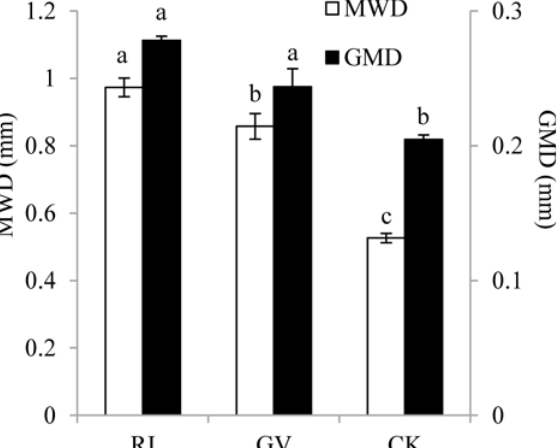
Fig 3. Mean weight diameter and geometric mean diameter of water stable aggregate in the rhizosphere of R . pseudoacacia colonized by R . irregularis (RI), G . versiforme (GV) or not (CV). Significant differences are indicated by different letters above the column (one-way ANOVA with Fisher ’ s LSD; P = 0.05; n = 3). MWD, mean weight diameter; GMD, geometric mean diameter. Replicate data is from S1